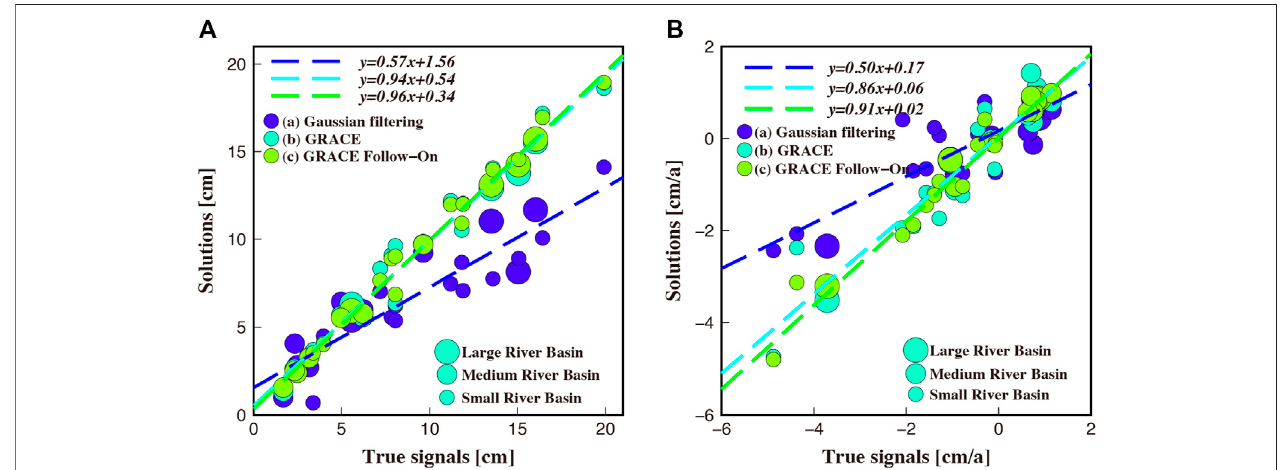
FIGURE 14 | Scatter plots of annual amplitudes (A) and trends (B) for the comparisons of true signals and solutions via different processing procedures: (a) simulated GRACE data after 500 km Gaussian fi ltering, (b) simulated GRACE data after applying improved forward-modeling method, (c) simulated GRACE Follow-On data after applying improved forward-modeling method. The regression lines are determined with 95% con fi dence